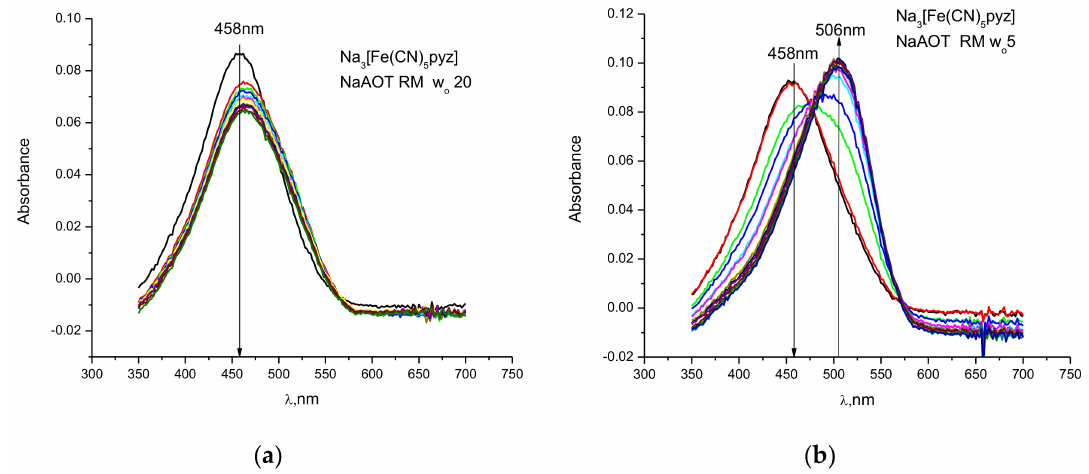
Figure 2. Hydrolysis of [Fe(CN) 5 pyz] 3 − in w 0 20 ( a ) and in w 0 5 ( b ) AOT/isooctane. The water concentration of [Fe(CN) 5 pyz] 3 − is approximately 10 − 4